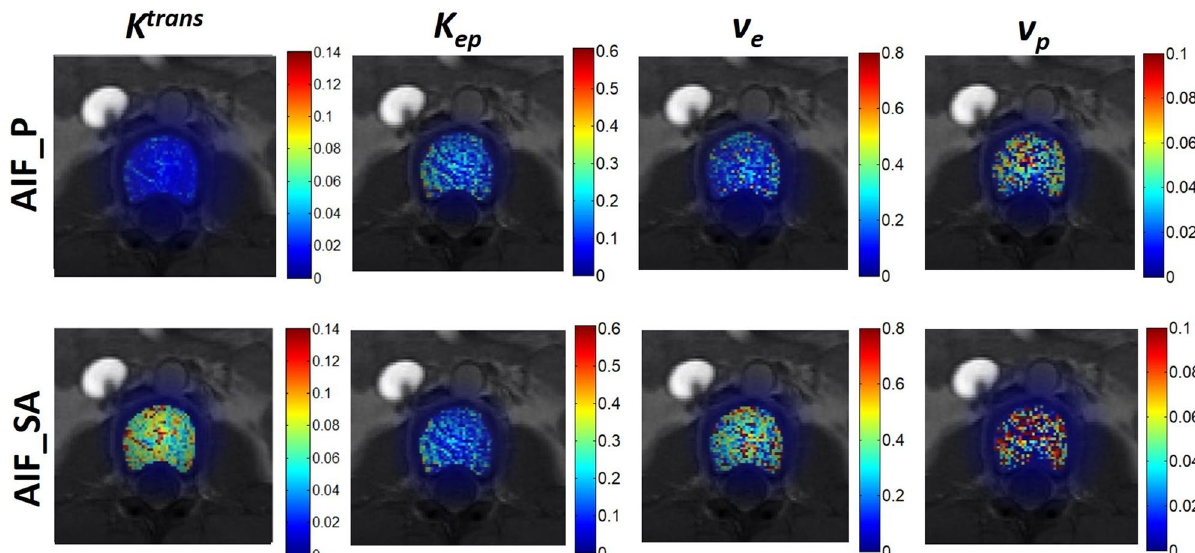
Figure 7. Maps of the perfusion parameters including K trans , K ep , v e , and v p for one participant, using an aortic arterial input function (AIF; top row) or a segmental arterial AIF (bottom